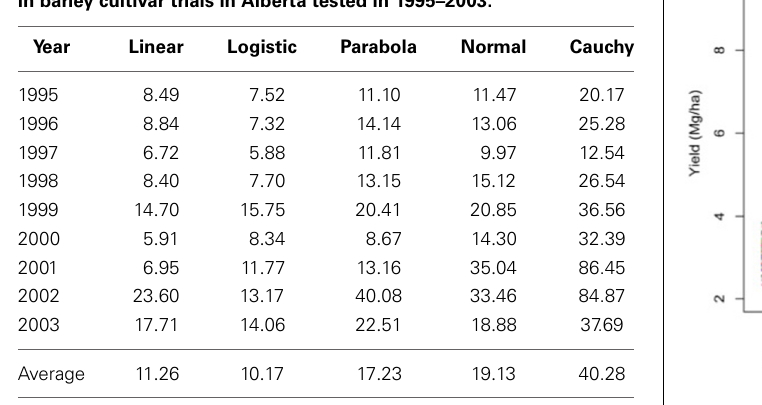
Table 1 | Percentages of genotype × environment interaction variation explained by linear function and four non-linear functions in barley cultivar trials in Alberta tested in 1995–2003.